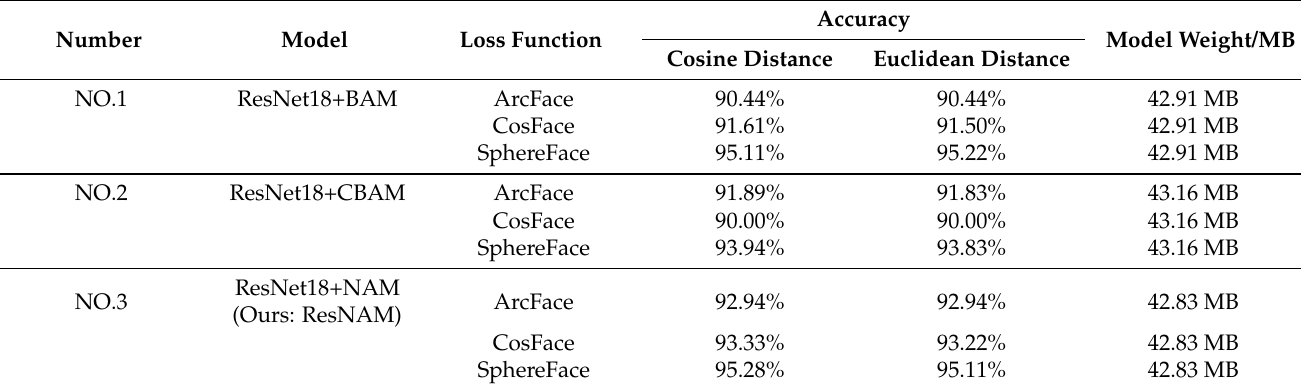
Table 3. Ablation experiment results for different models.